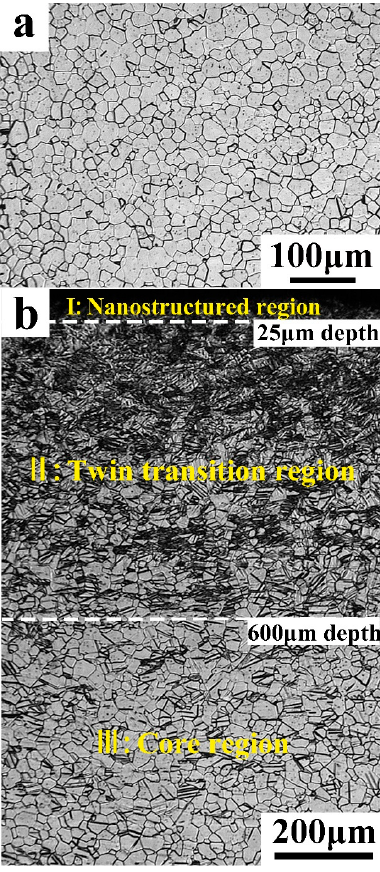
Figure 1. Optical micrographs of: ( a ) the as-annealed Ti, and ( b ) the rotationally accelerated shot peening (RASP)-processed Ti.